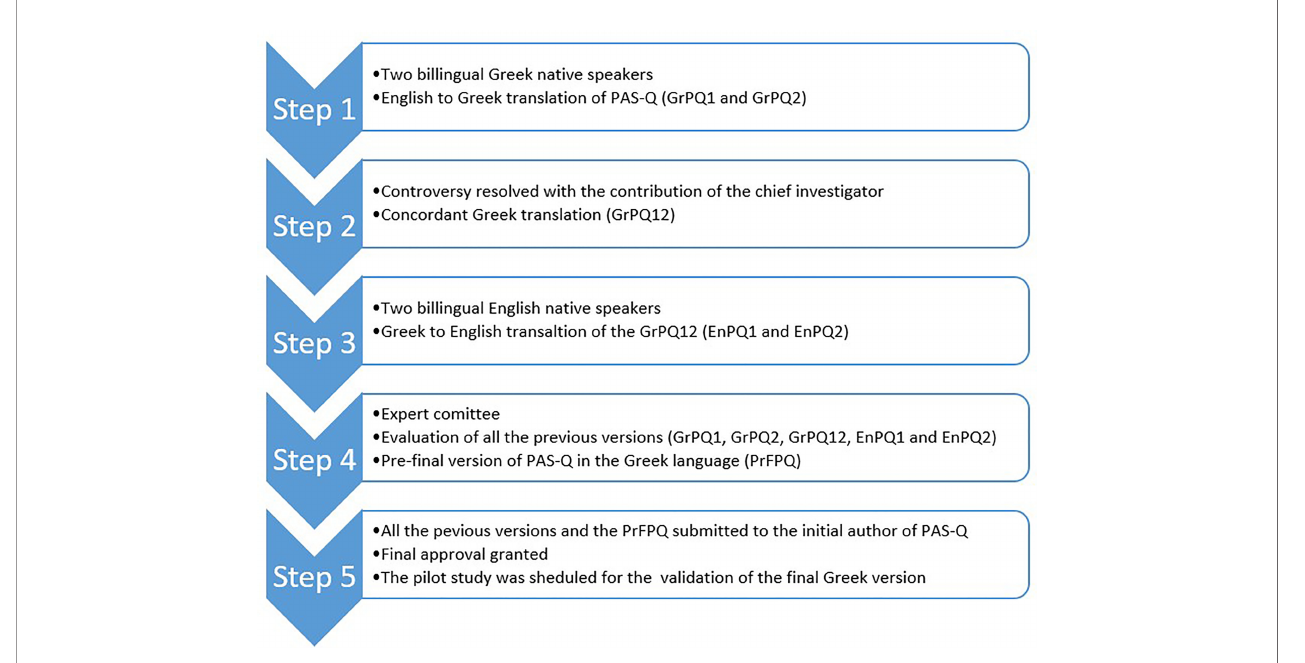
FIGURE 1 | Translation and adaption procedure of